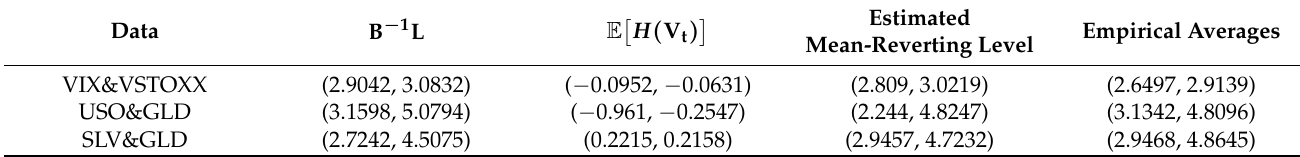
Table 9. Estimated original drift group